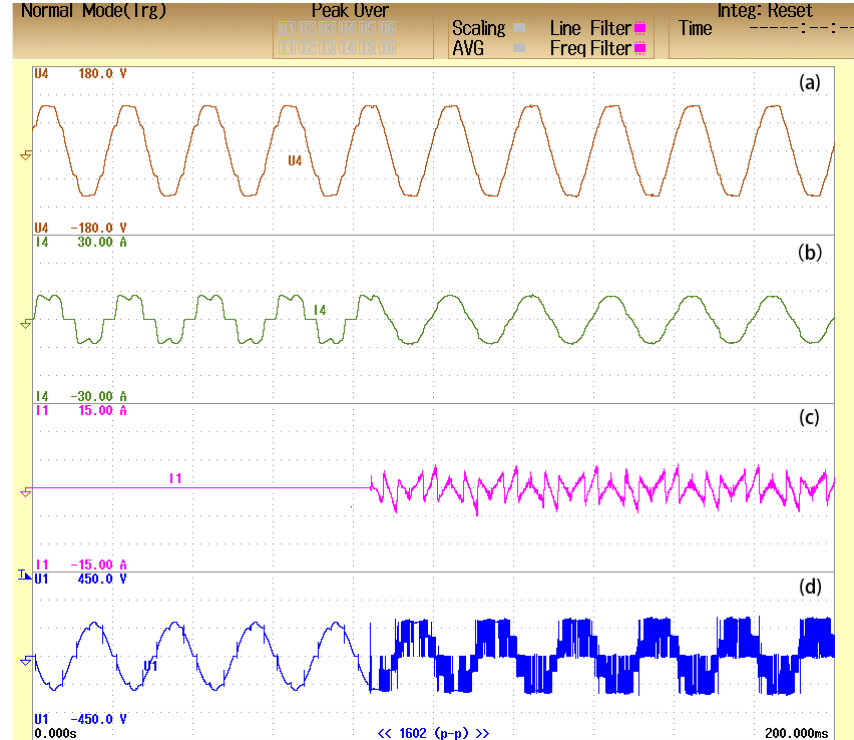
Figure 11. Single Phase ( a ) Supply Voltage ( b ) Supply Current ( c ) Compensator Current ( d ) Compensator Voltage.